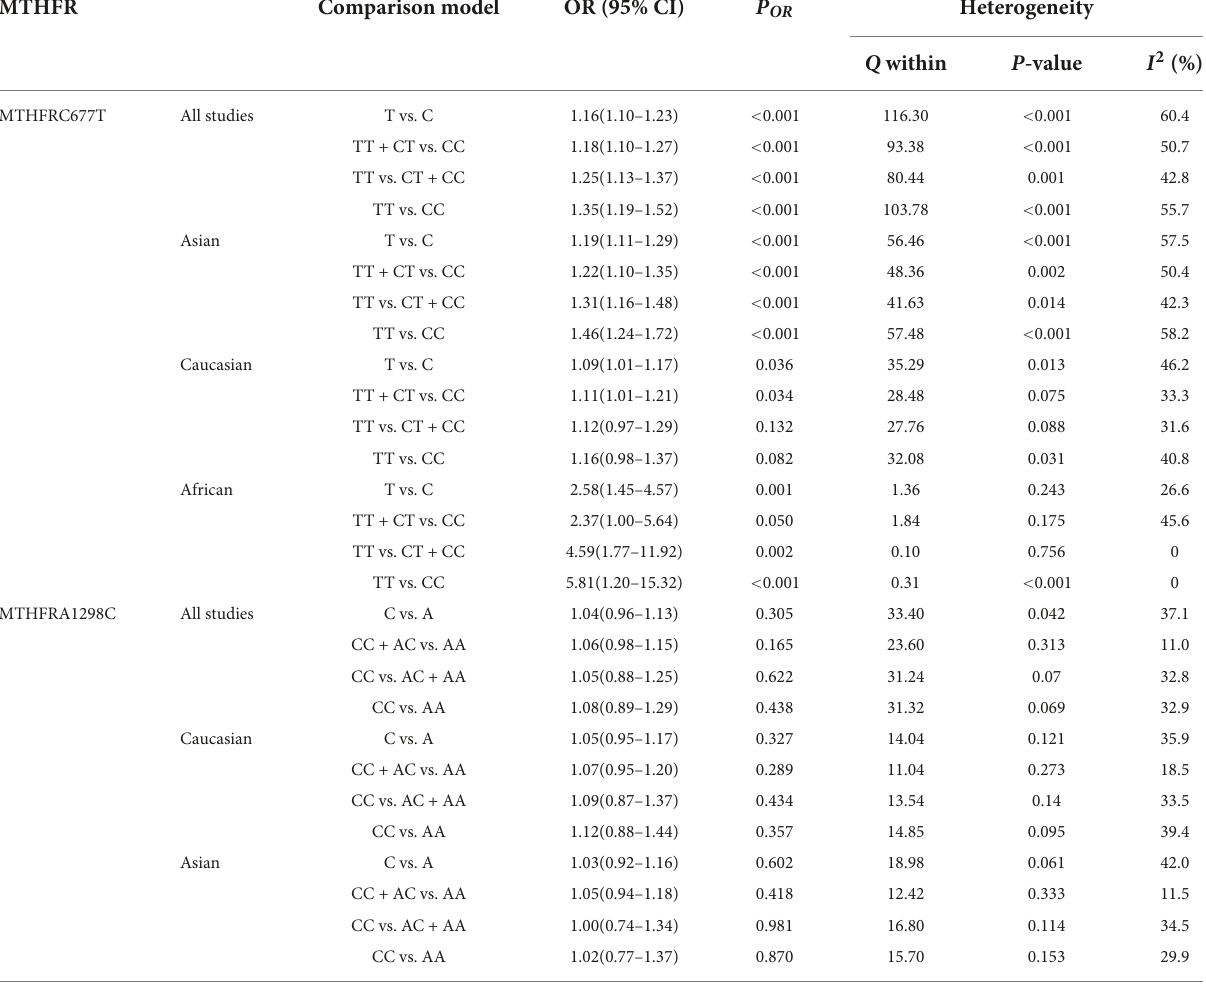
TABLE 3 Odds ratios and heterogeneity results for the 4 genetic models of the MTHFR C677T and A1298C for SZ.